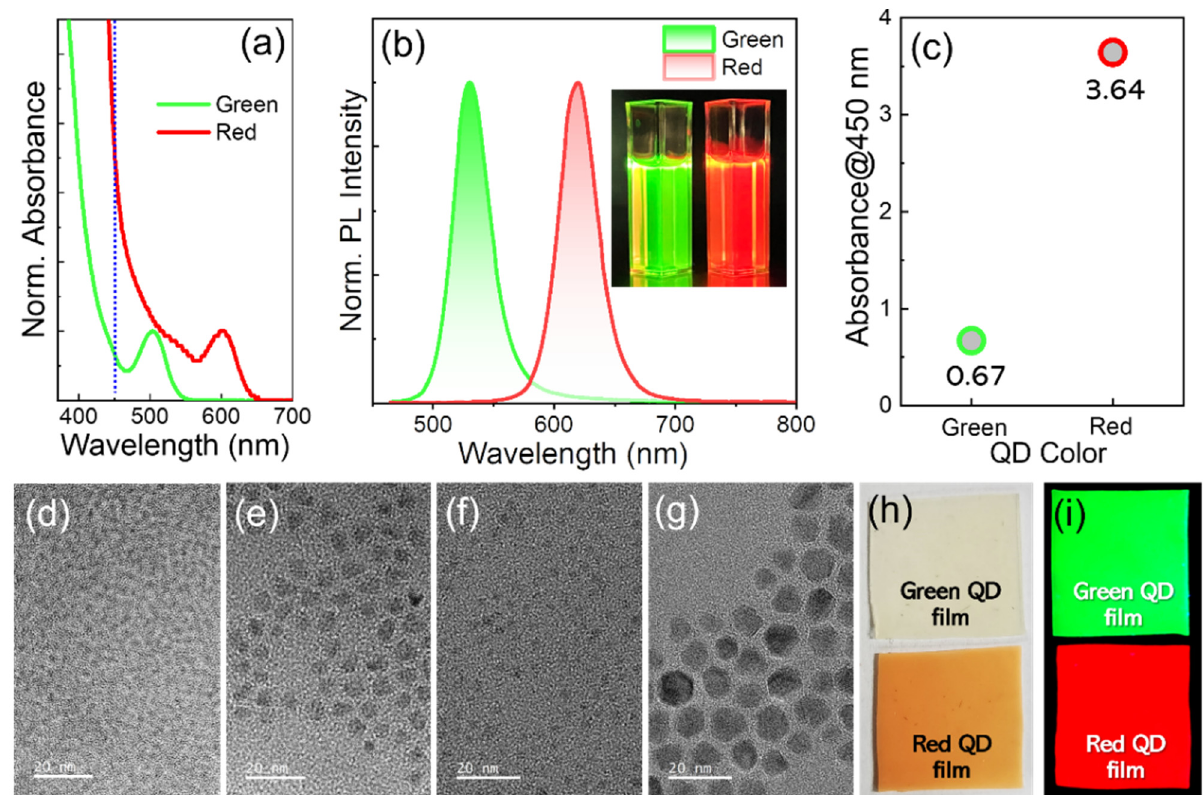
Figure 1. Normalized ( a ) absorption and ( b ) PL spectra of green and red InP/ZnSe/ZnS QDs. ( c ) Their absorbance values at 450 nm obtained from ( a ). TEM images of green-emissive ( d ) InP cores, ( e ) InP/ZnSe/ZnS core/shell QDs and red-emissive ( f ) InP cores and ( g ) InP/ZnSe/ZnS core/shell QDs (scale bars are 20 nm for all). Green and red QD polymeric films under ( h ) room light and ( i ) UV irradiation.